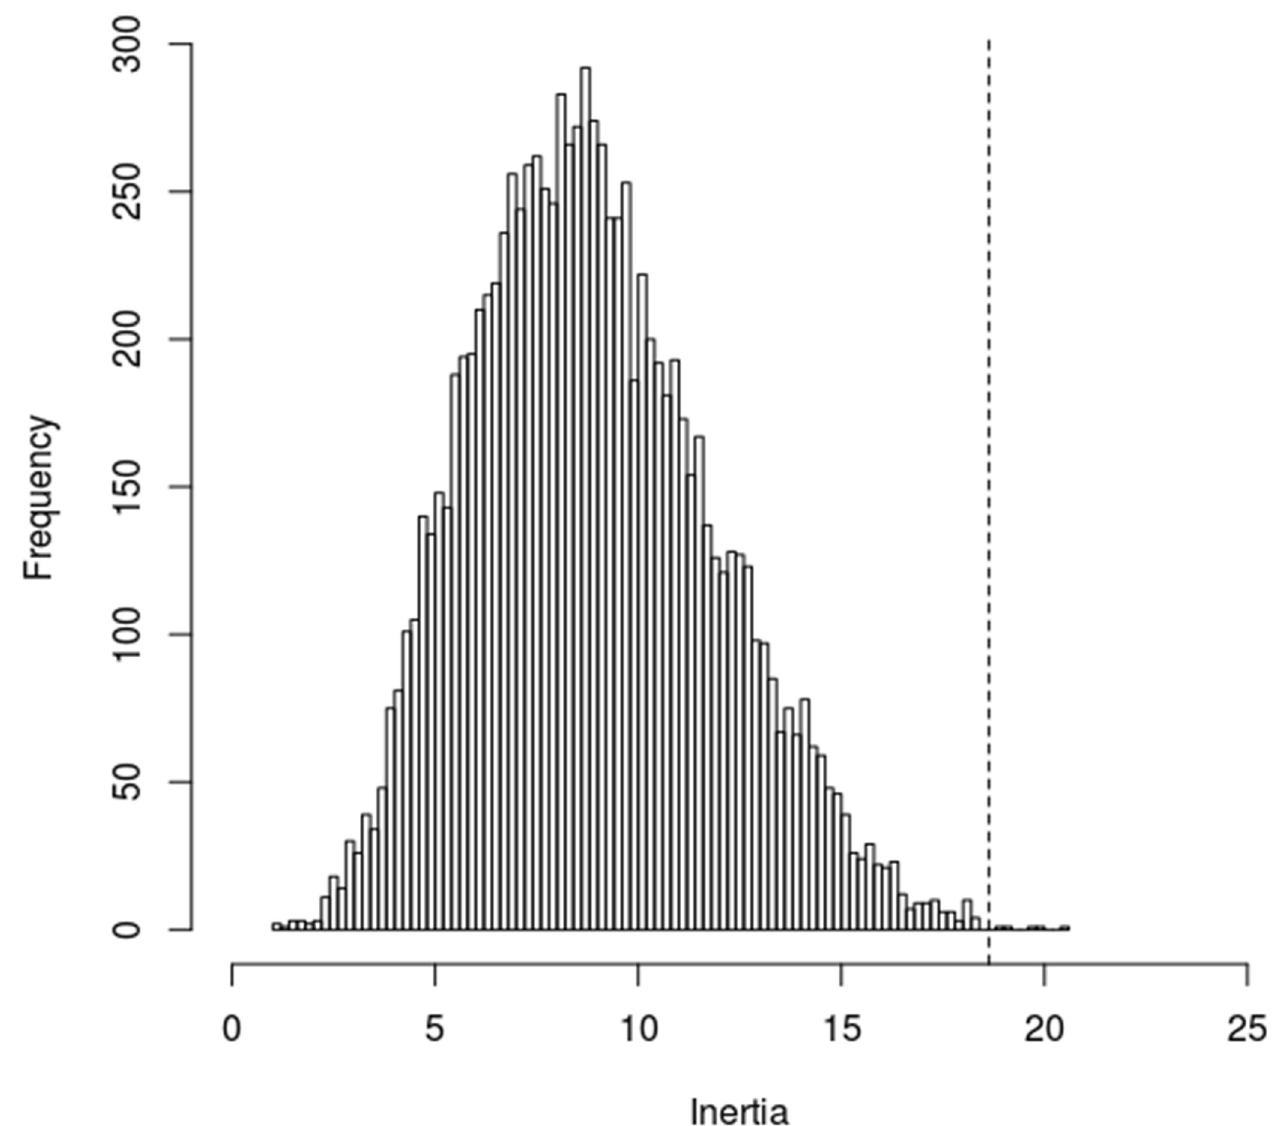
Fig 1. Singular value inertial value (indicated by dotted line) computed from the observed data and the null-distribution of the inertia computed using a permutation test with 10,000 permutations.